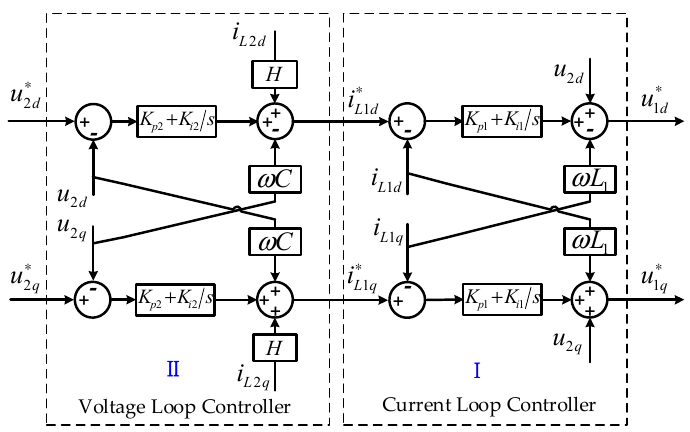
Figure 2. Diagram of voltage- and current loop controller.